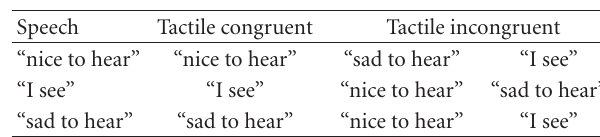
Figure 6: Means and SEMs for the ratings of the stimulus dominance. Table 2: Emotional content of the speech sample, and the congruency of the concurrent tactile